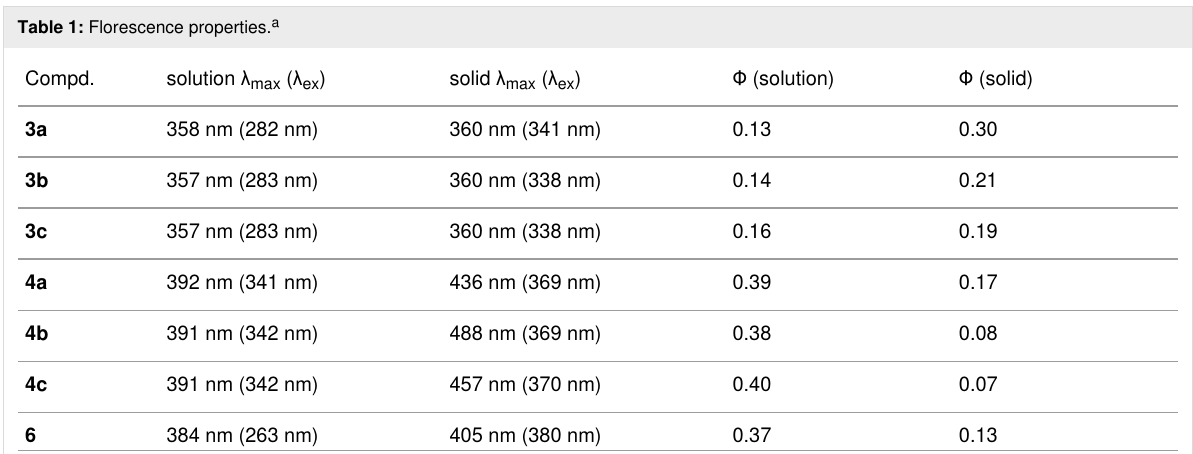
Table 1: Florescence properties. a